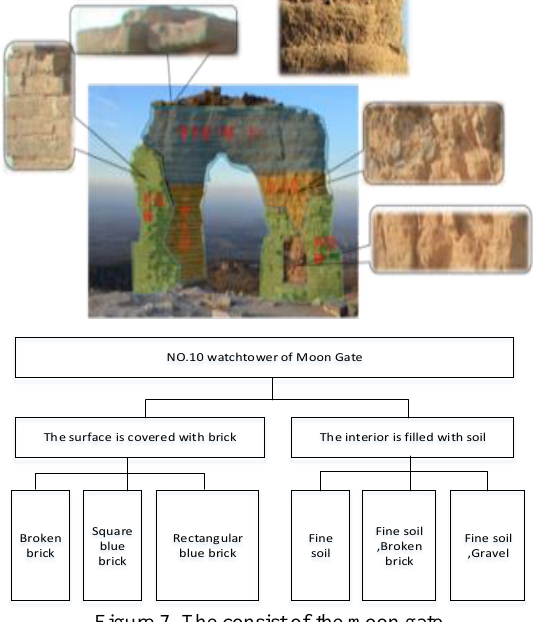
Figure 7. The consist of the moon gate